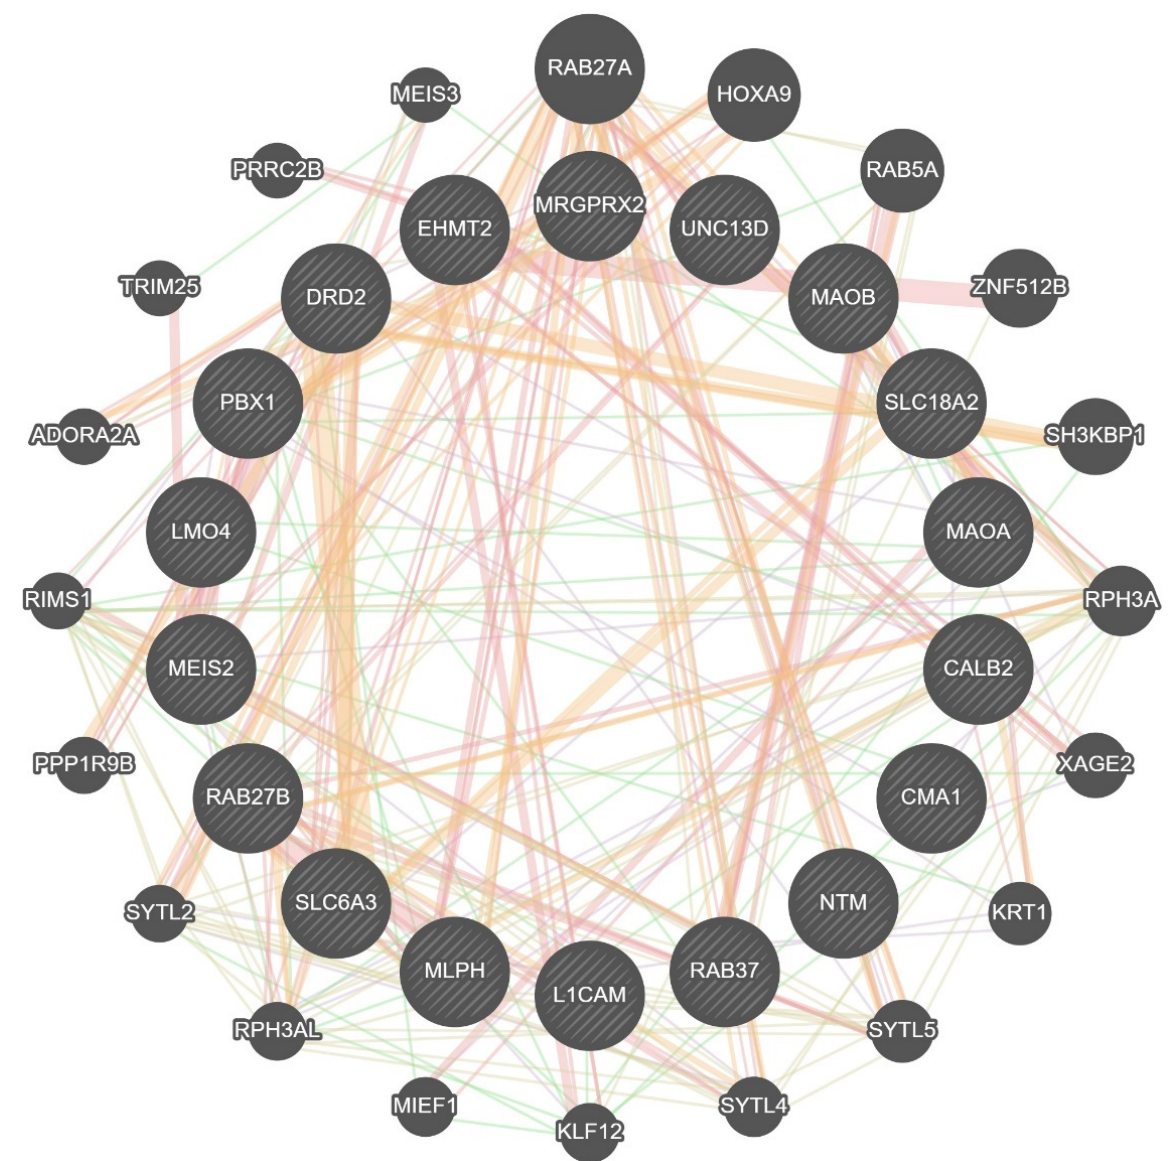
Figure 7. Protein–protein interaction network based on the GeneMANIA web server. To find putative interactions of selected neuronal genes with other partners, network analysis was performed using the GeneMANIA web server [246]. Each gene is a node and evidence for interactions between protein pairs are edges. The thickness of the edges indicates the strength of the interaction, the color of the edges indicates the type of interaction, and the size of the nodes distinguishes the hub gene (inner circles) from the predicted genes (outer circles). Several of the predicted genes are transcribed in MCs (e.g., ADORA2A, SYTL4, KRT1, and MIEF1, and some at substantial levels, e.g., SYTL2).